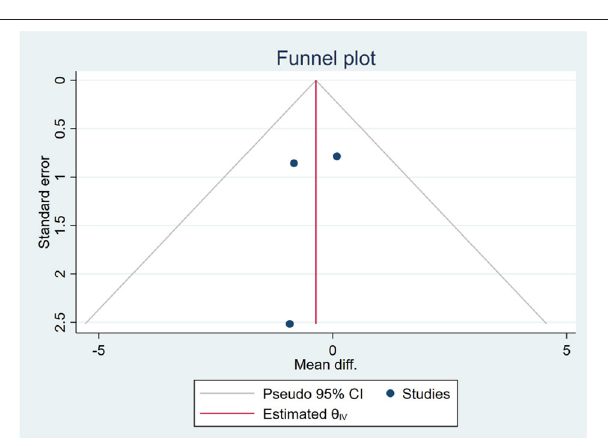
FIGURE 18 | Funnel plots of the effect of body mass index (BMI).